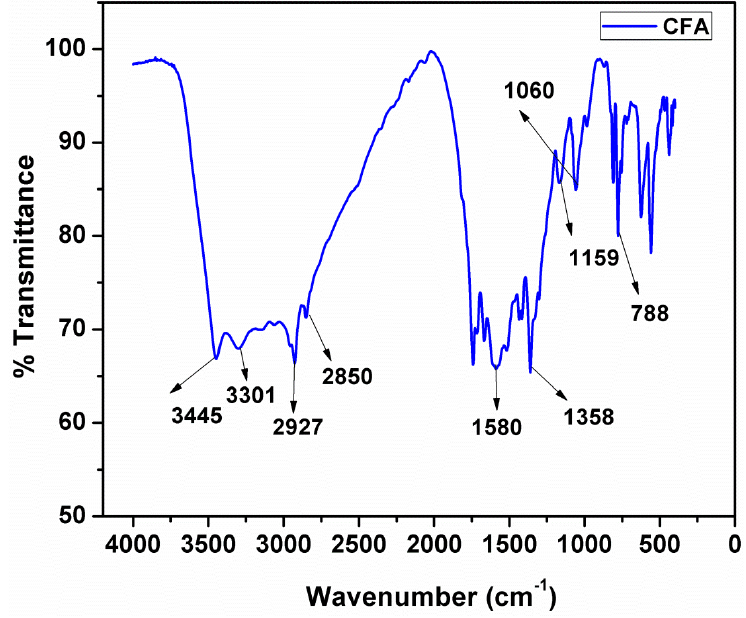
Figure 4. FT-IR curve of and charring foaming agent (CFA).